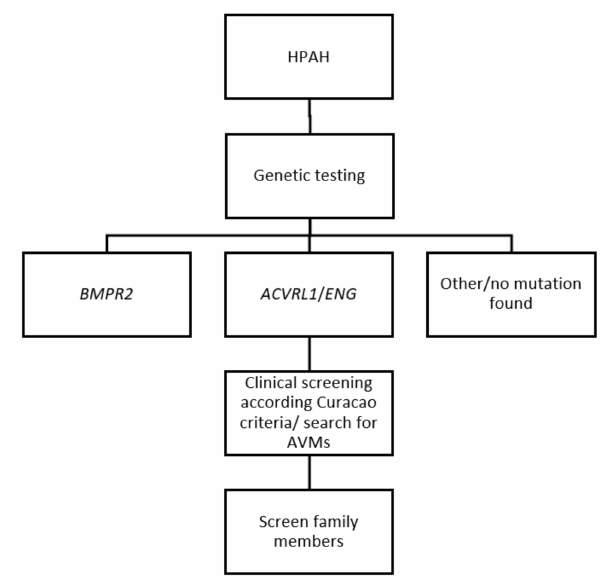
Figure 3. Diagnosis of HHT in HPAH. HPAH, heritable pulmonary arterial hypertension; AVMs, arteriovenous